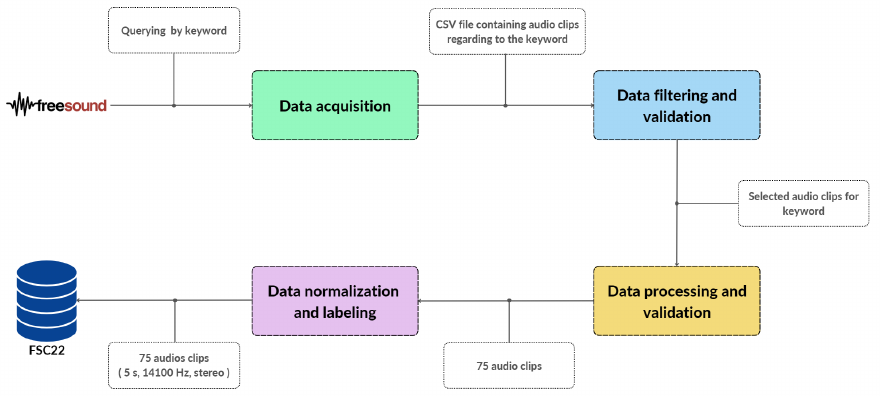
Figure 5. Overall